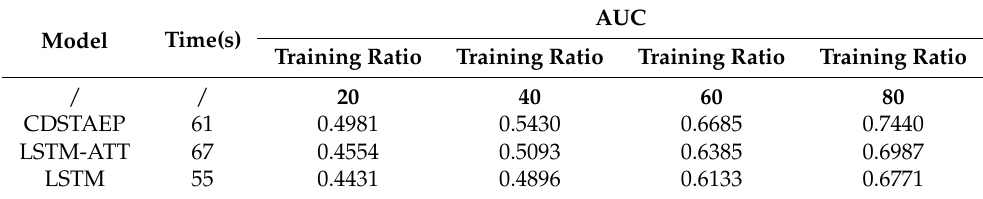
Figure 8. Comparison of prediction effects of different models: the horizontal axis is the training ratio, and the vertical axis is the AUC score. Table 7. Time efficiency and AUC for different classifiers on the dataset.